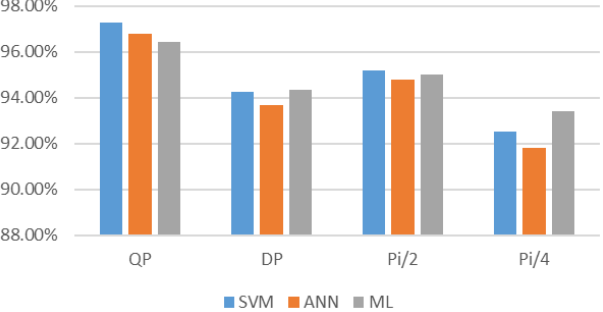
Figure 6. Classification accuracy of different polarimetric SAR modes achieved by SVM, ANN and ML.